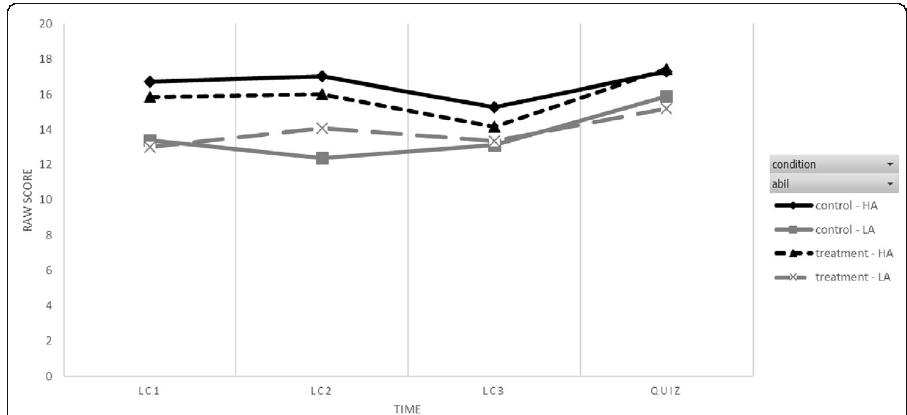
Fig. 2 Plot of mean raw score for chemistry students ’ performance over